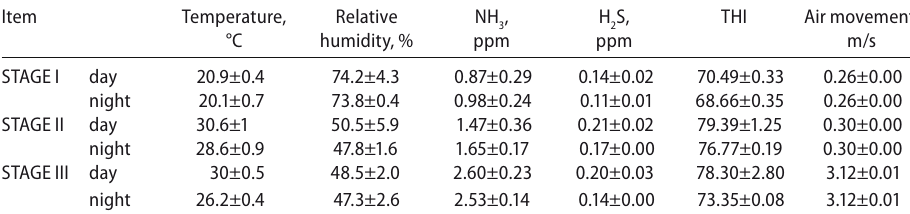
Table 1 Summary of environmental parameters for different stages of the